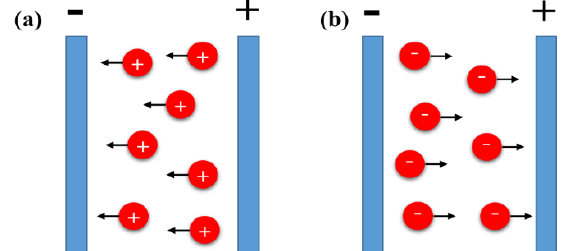
Figure 1. Schematic diagram of the electrophoresis process: ( a ) cathodic electrophoresis and ( b ) anodic electrophoresis.